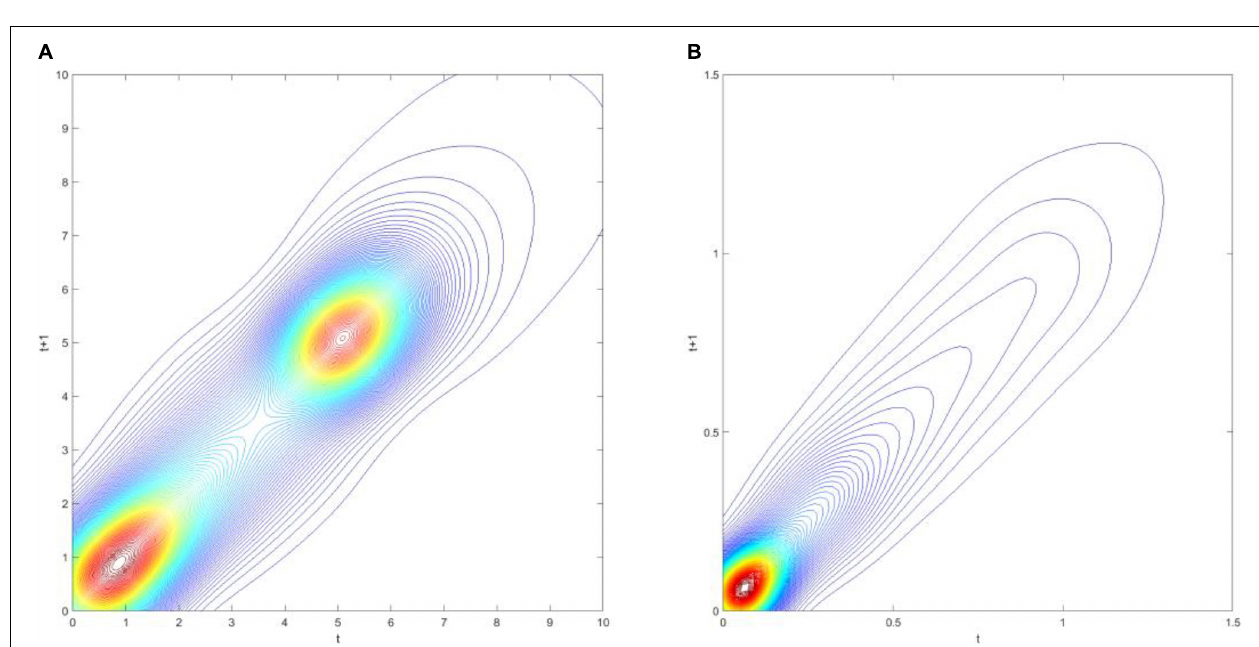
FIGURE 7 | Three-dimensional plot of transition probability kernel for the relative RSVAPC of countries for the Global North (A) and the Global South (B) with annual transitions. Source: Authors’ calculation.